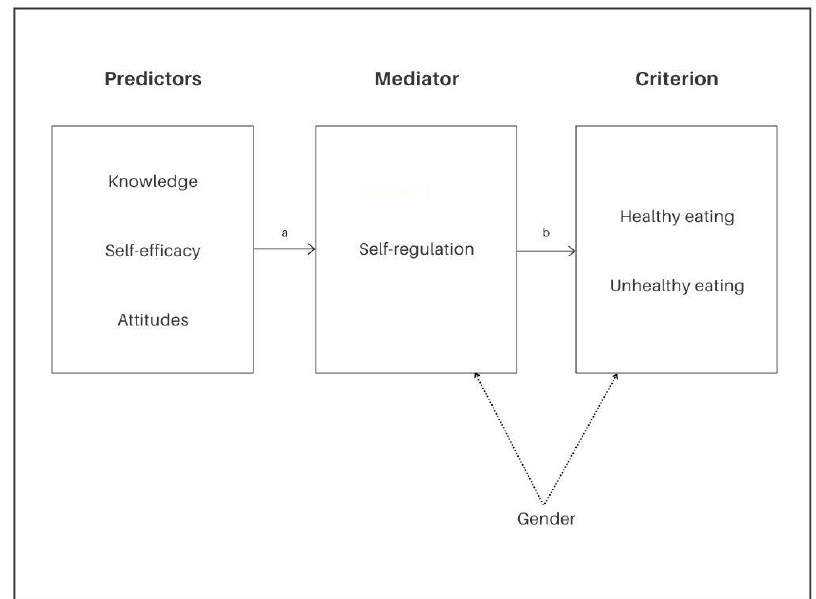
Figure 1. Explanatory model of the mediational role of the self-regulation processes toward healthy eating on the relationship between the predictor factors (i.e., declarative knowledge about healthy eating, self-efficacy processes toward heathy eating, and attitudes and perceptions on healthy eating) and the food consumption criterion variables (healthy and unhealthy eating). Note. Coefficients a and b are expected to be statistically significant; gender was treated as a covariate to statistically control its